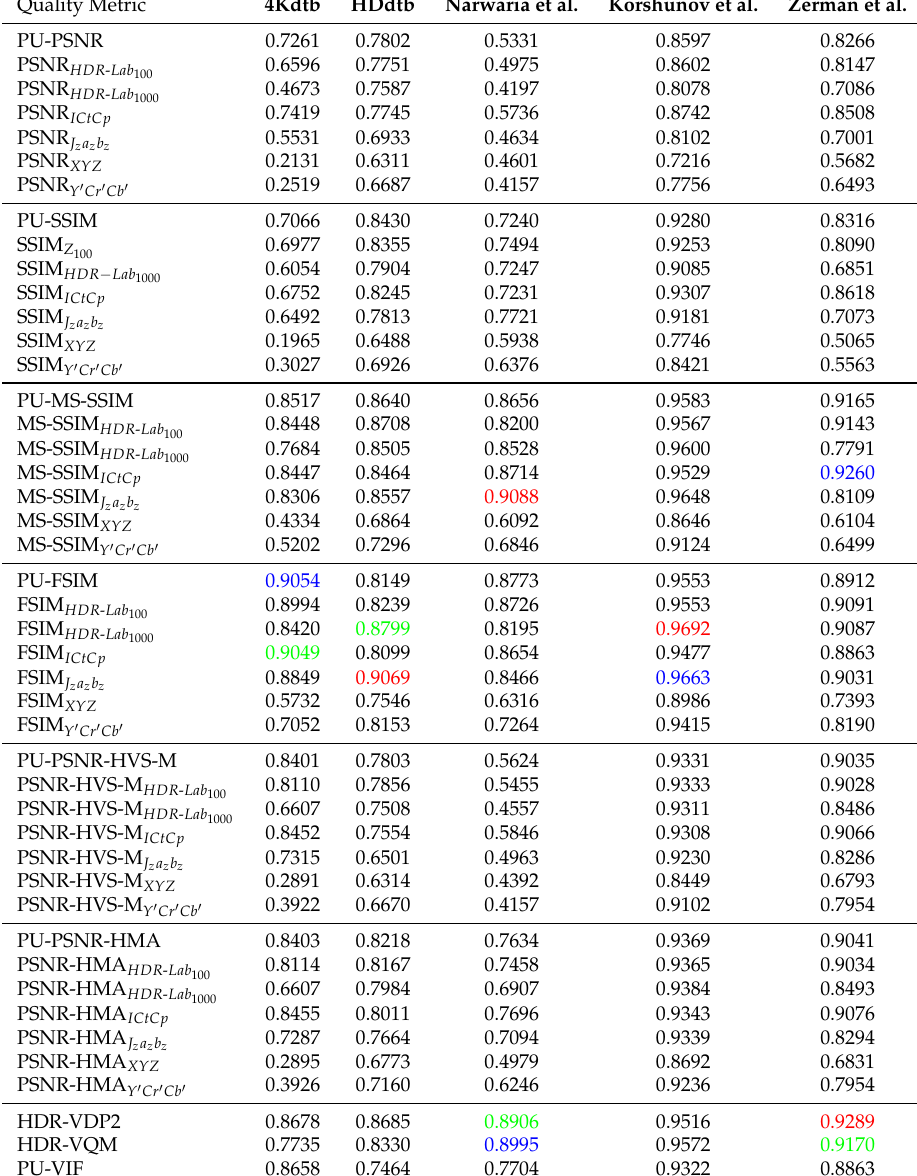
Table A3. SROCC of the different color-blind quality metrics on the considered databases. Quality